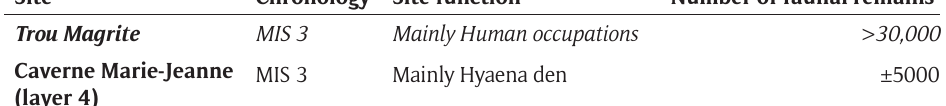
Table 1: Short presentation of the two old faunal collections included in this study.